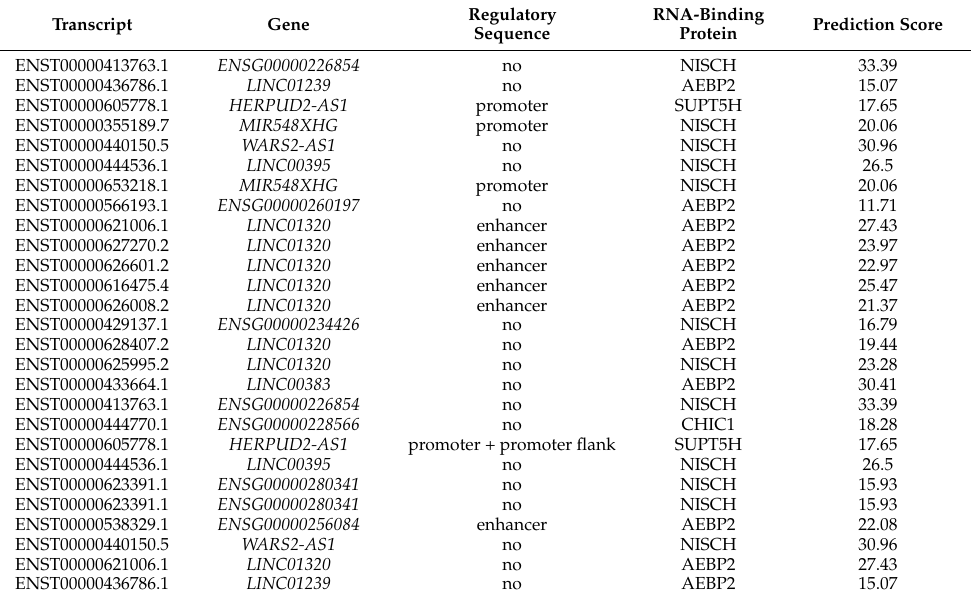
Table 2. LncRNA transcripts complementary to syncytin-1 gene that were predicted to interact with RNA-binding proteins (AEBP2: AE-binding protein 2; CHIC1: cysteine-rich